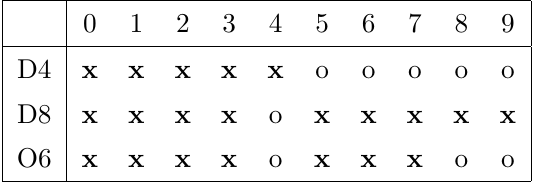
Table 2. Brane realization of holographic QCD with symplectic or orthogonal gauge group. In a) N color D4 branes intersect an orientifold O6 to project to a real gauge group. In b) the same branes are embedded in the dual R 3 ; 1 (cid:2) D 2 (cid:2) S 4 geometry, together with D6 branes dual to the (cid:18) -interfaces. Also indicated are (cid:13)avor D8 branes that would be needed to add additional (cid:13)avors. t